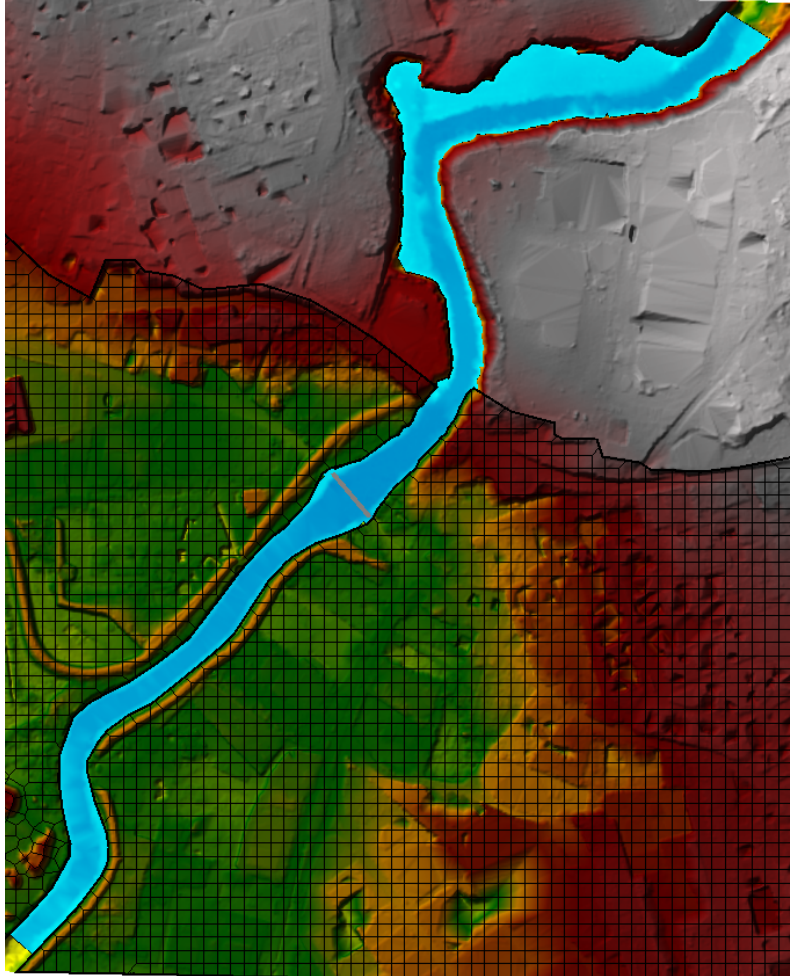
Figure 6. HEC-RAS representation of the water surface elevation of the Aniene river after the simulation with optimised Manning’s n